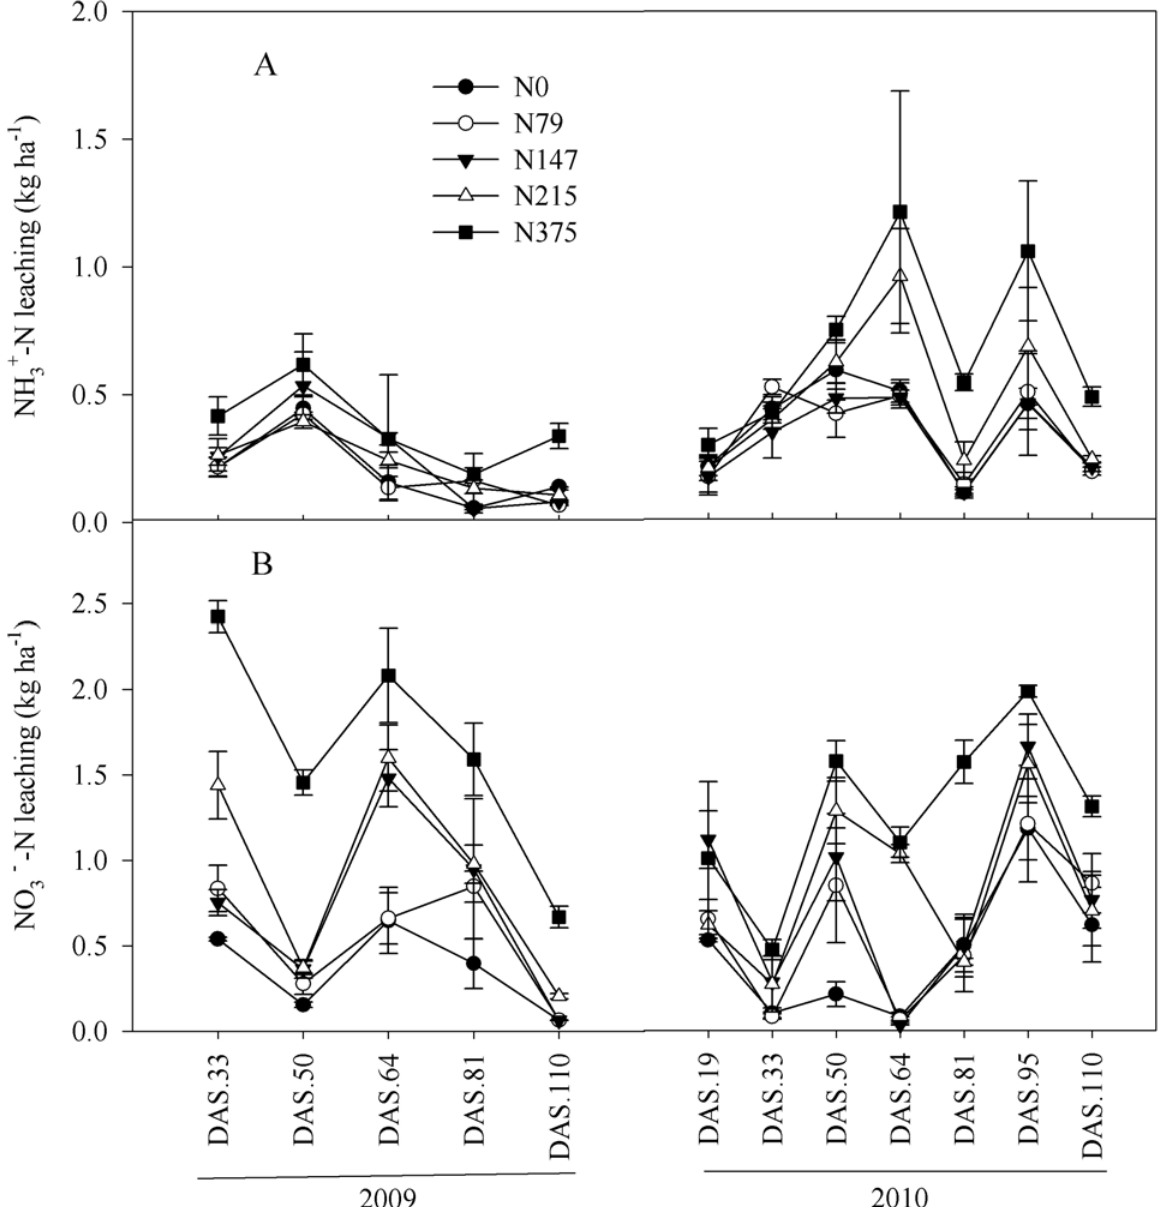
Fig 4. Leaching dynamics of NH4 + -N (A) and NO3 - -N (B) at different days after sowing (DAS) during maize growth in 2009 and 2010. Each point is mean of 4 replicated plots. Error bars represent ± 1